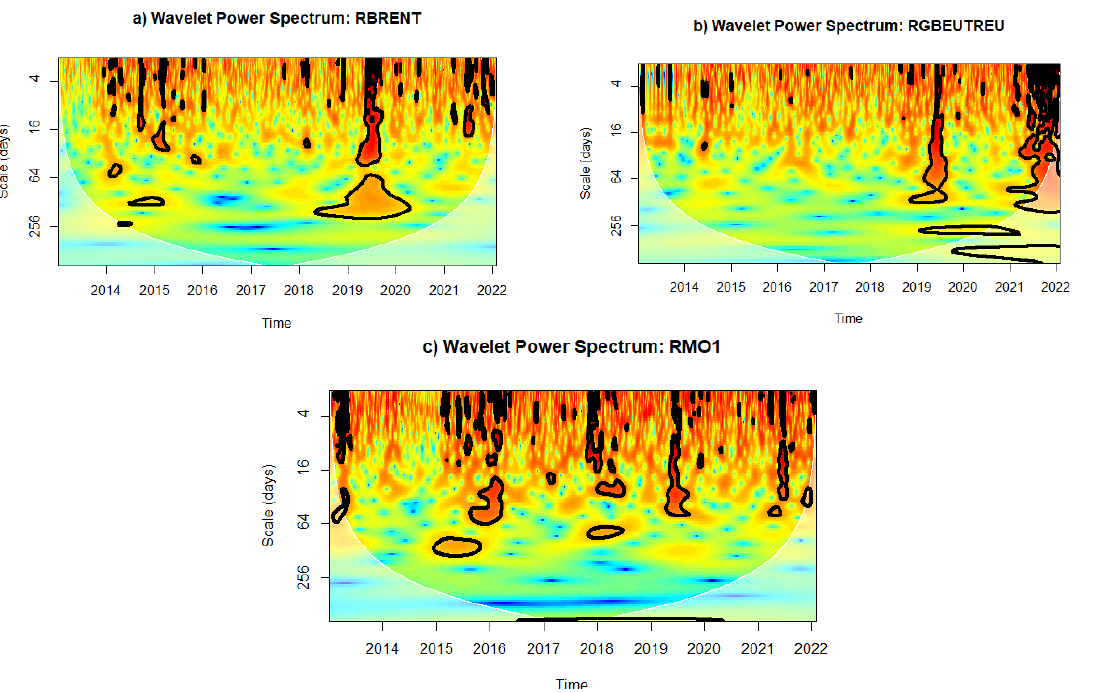
Figure 6. Wavelet power spectrum for Brent oil returns (RBRENT), Green Bond Index (RGBEUTREU), and CO 2 futures’ returns (RMO1). Source: Authors’ own research using data from Bloomberg.